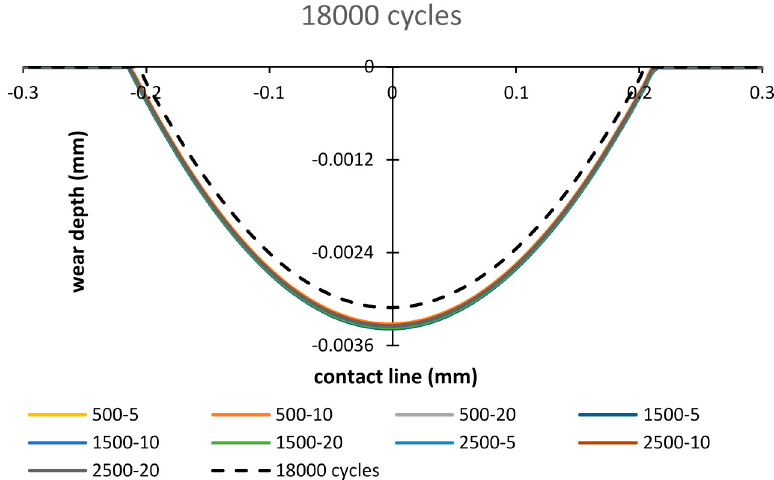
Figure 16. Wear scar after 18,000 cycles based on debris layer model: importing time = 500, 1500, 2500 cycles and layer thickness = 5 µm, 10 µm, 20 µm.